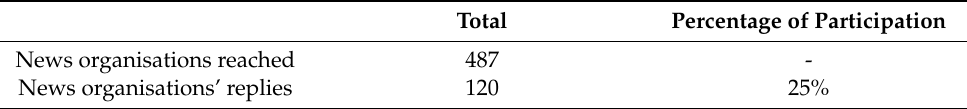
Table 3. Overall Data Collection Summary.